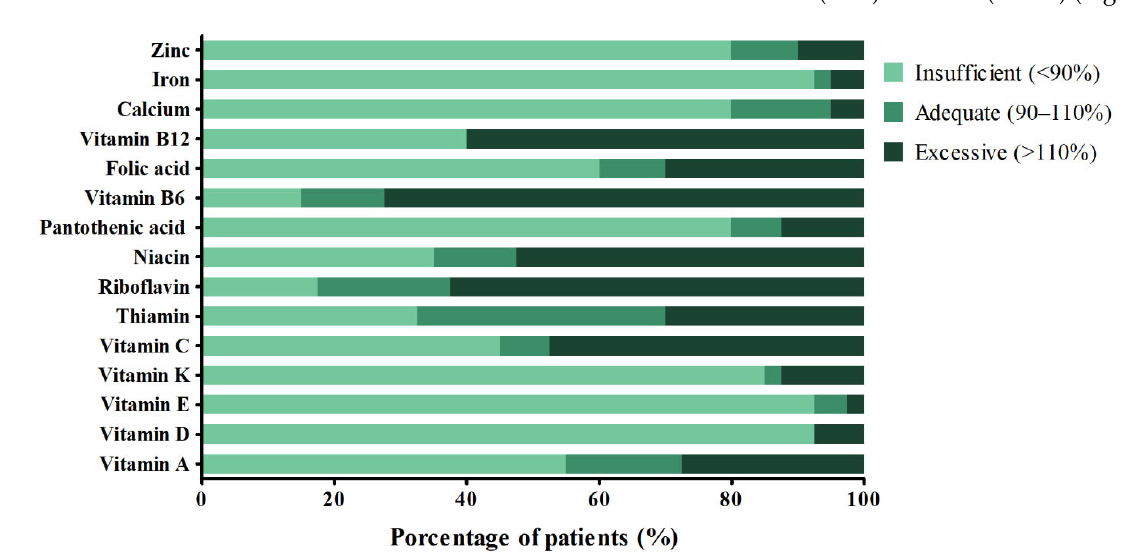
Figure 1. Prevalence of adequate micronutrient intake. The percentage of adequacy of each patient was classified as: <90%, insufficient intake; 90 to 100%, adequate intake; >110%, excessive intake. The figure shows the percentage of patients in each of these categories.